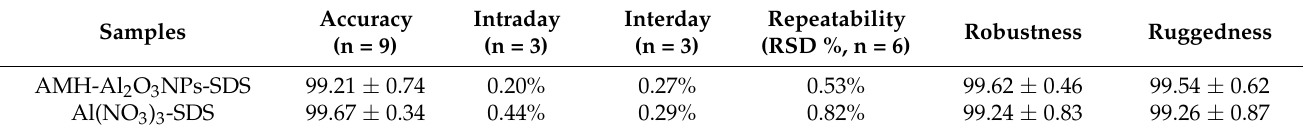
Table 2. Response data obtained from the determination of AMH using the proposed spectrofluo- Table 3. Results of validation calculated from the determination of AMH in authentic samples using the proposed spectrofluorometric AMH-Al 2 O 3 NPs-SDS and AMH-Al(NO 3 ) 3 -SDS